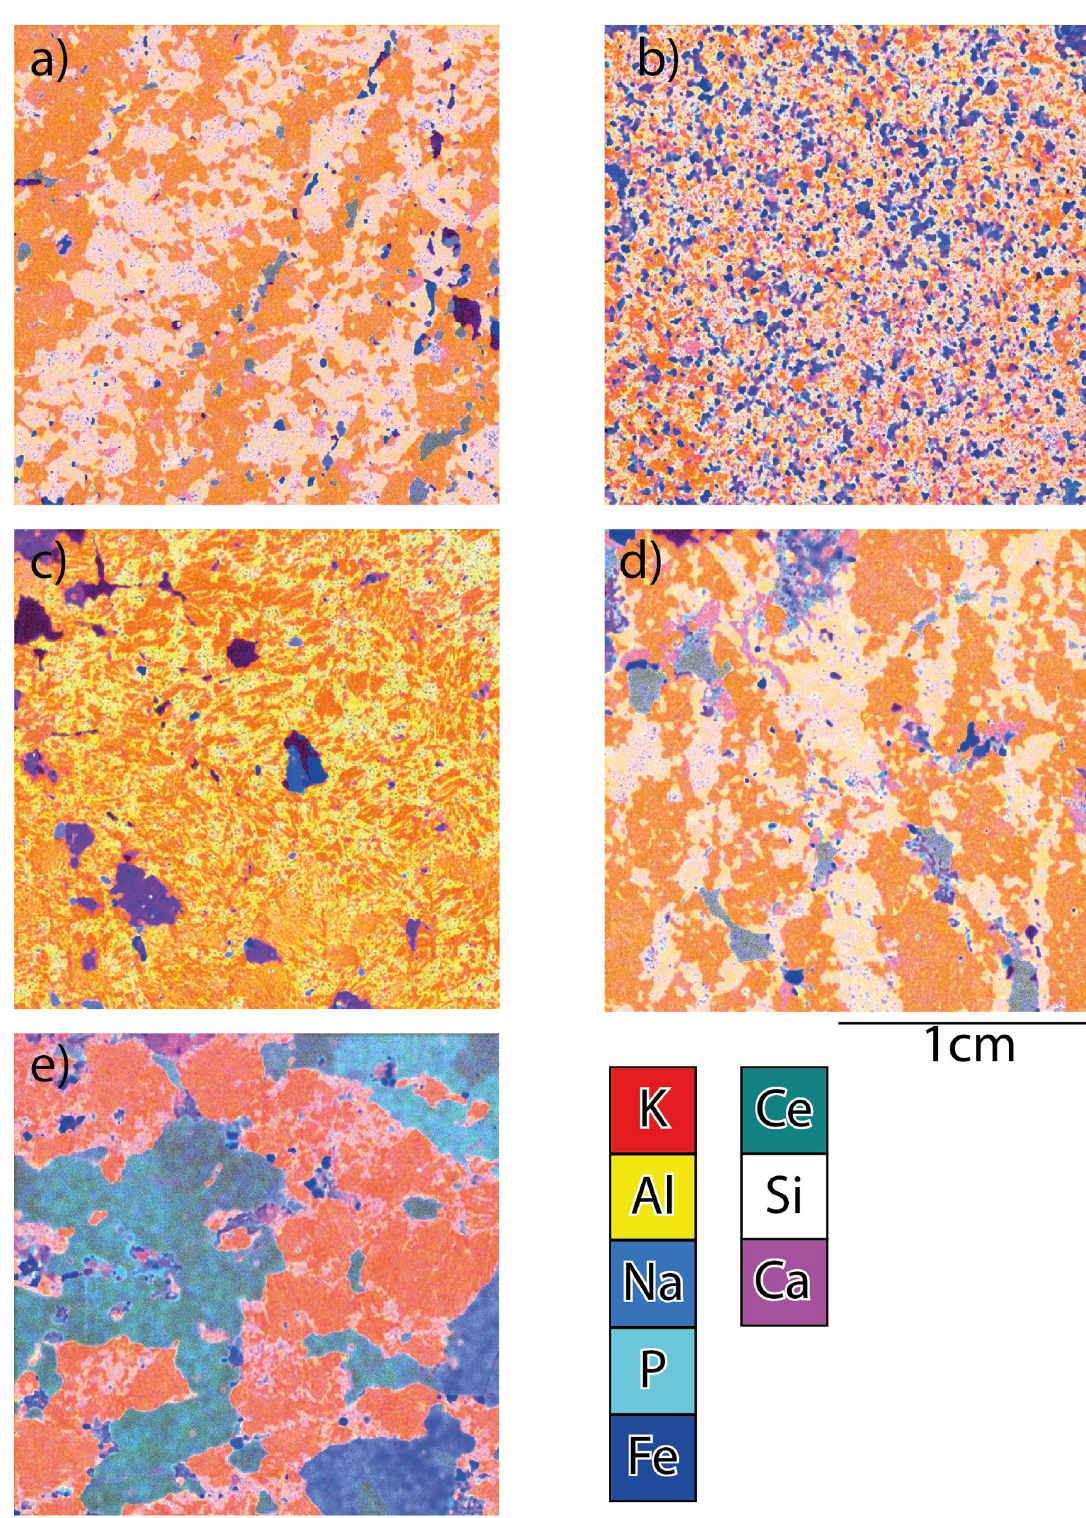
Figure 3. µXRF mapping in false color showing the texture and granulometric variation in the different alkaline intrusions. Methodology for mapping can be found in Section 2.3. ( a ) Wemotaci Intrusion Suite, ( b ) Rheaume Intrusive Suite, ( c ) Core Syenite, ( d ) Bouvreuil Syenite, and ( e ) Bourguet Syenite.